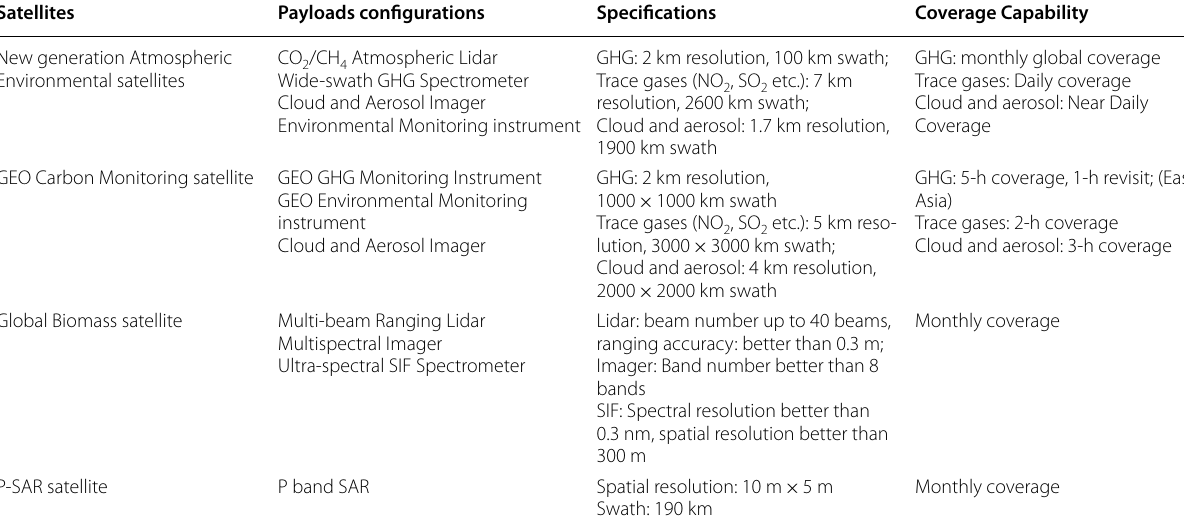
Table 6 Major payload configuration and specifications of the core satellites